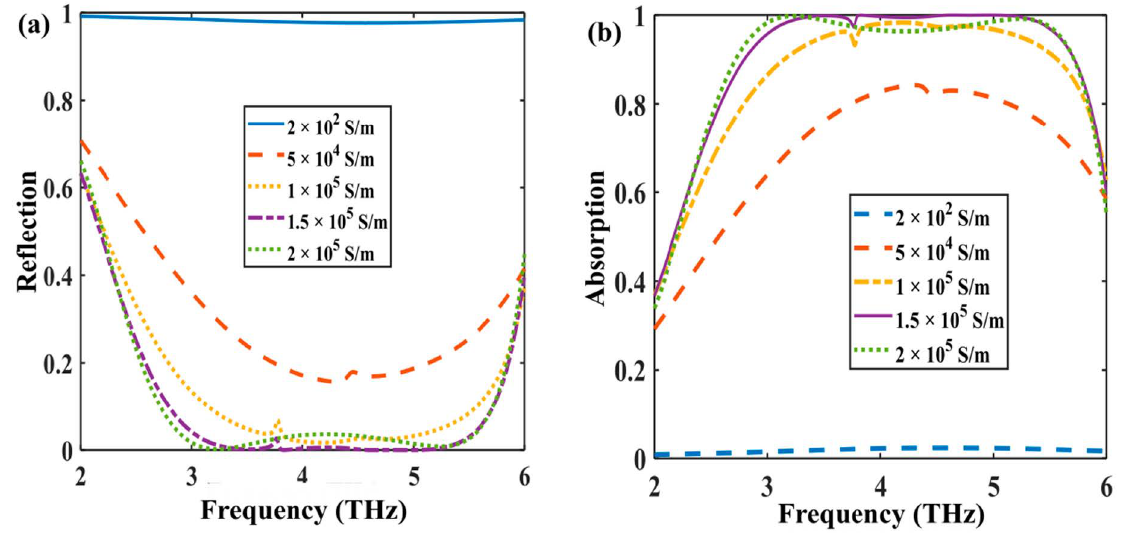
Figure 4. ( a ) Numerical reflection spectra and ( b ) absorption spectra of VO 2 at various conductivities.